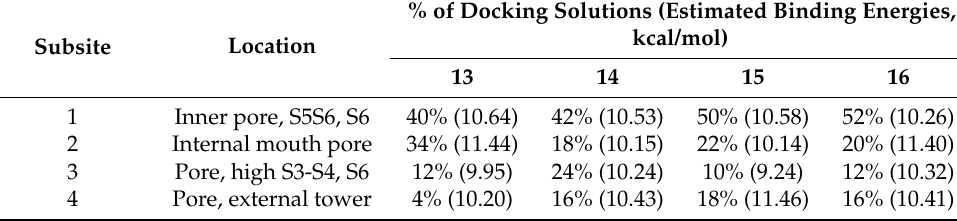
Table 4. Main sites found for compounds 13 – 16 , and statistical distribution of the docking solutions. % of Docking Solutions (Estimated Binding Energies, Subsite Location